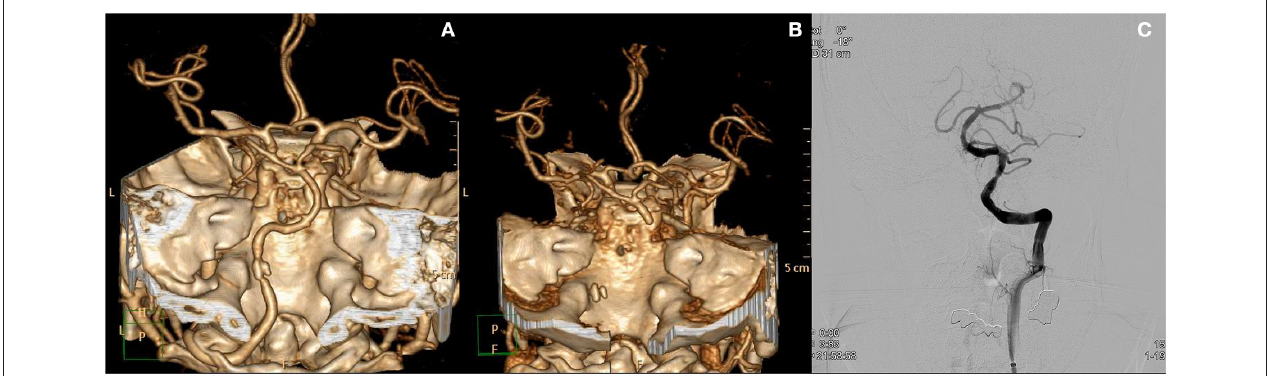
FIGURE 1 | Case of a patient who presented with prodromal acute vestibular syndrome. (A) Initial CT angiography revealed focal calcified plaque at the left distal vertebral artery with stenosis. The patient was discharged from the ED. Three days later, the patient revisited the ED with newly onset major neurological deficits. (B) CT angiography at that time show occlusion from the left vertebral artery to the distal basilar artery. (C) Recanalization of basilar and vertebral arteries after endovascular